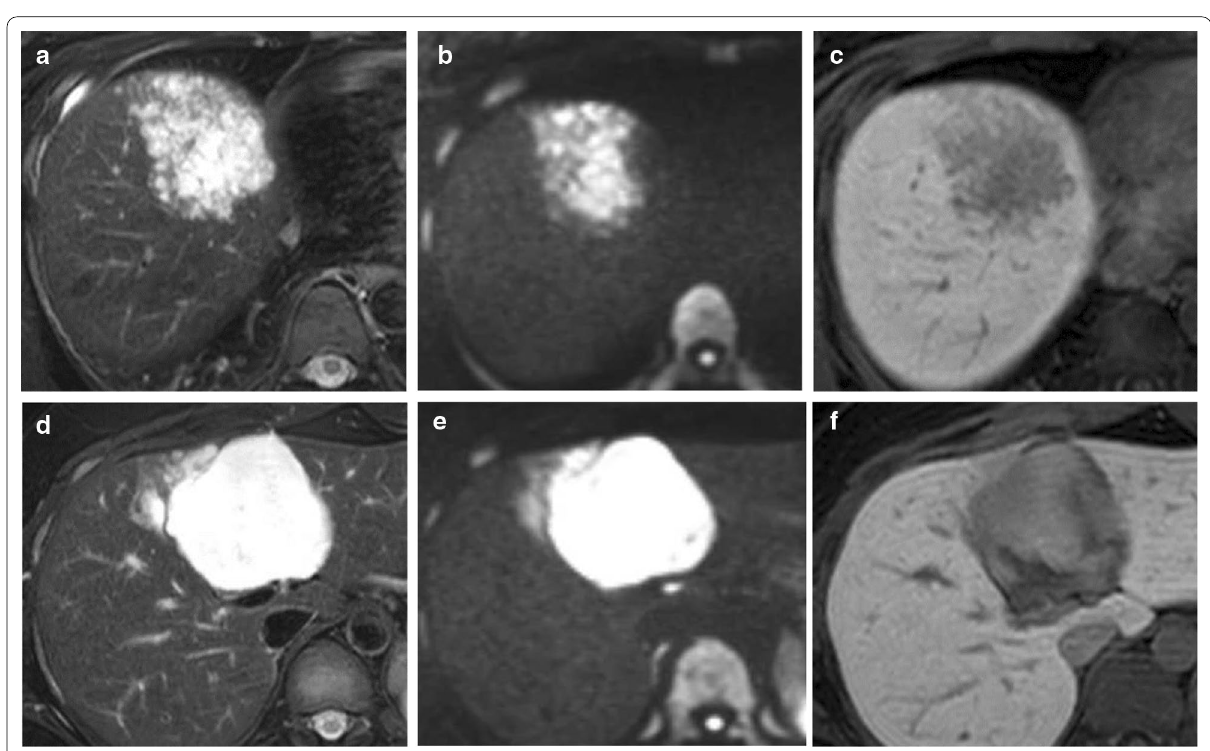
Fig. 3 MRI findings. a – c In liver segment IVa, a T2-weighted image shows scattered high signal intensity ( a ). The lesions also show high signal intensity on diffusion-weighted images ( b ) and in the hepatobiliary phase of Gd-EOB-DTPA ( c ). d – f In liver segment IVb, T2-weighted and diffusion-weighted images show well-defined lesion with high signal intensity ( d , e ). The lesion is iso signal intensity in the hepatobiliary phase of Gd-EOB-DTPA ( f )